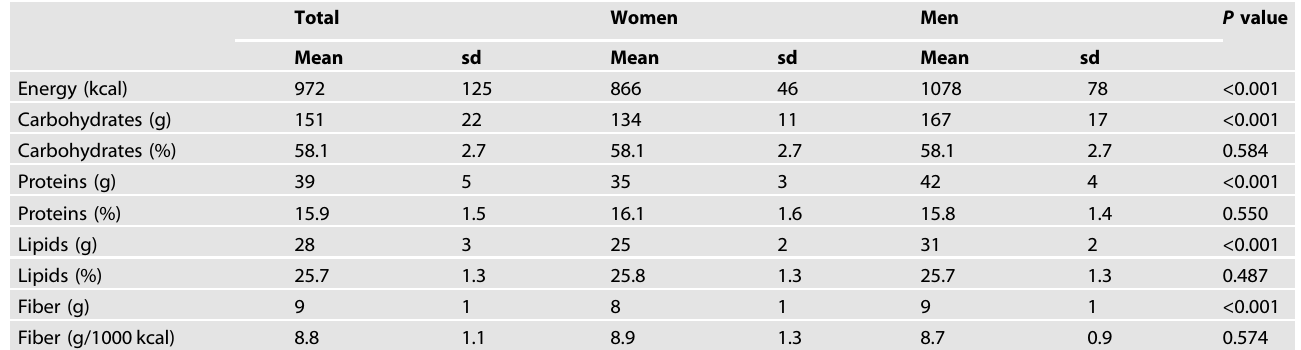
Table 1. Energy and macronutrients composition of the test